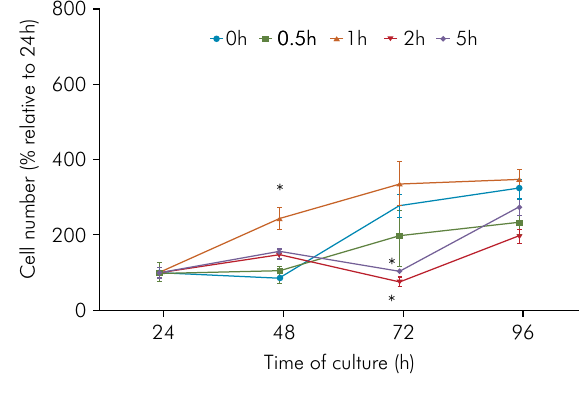
Figure 3. Comparison of cell viability among different times of pulp extraction and different times of cell culture. Data were normalized with the first day of cell culture (24 h) and expressed as mean ± standard error of two independent experiments performed in triplicates.